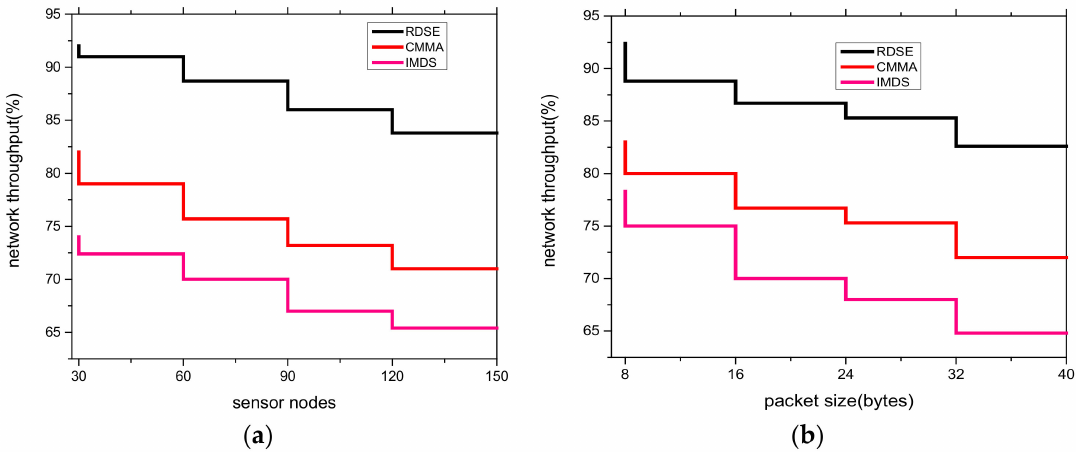
Figure 3. Network throughput with ( a ) varying sensors “30–150” and ( b ) varying packet sizes “8–40 bytes”.